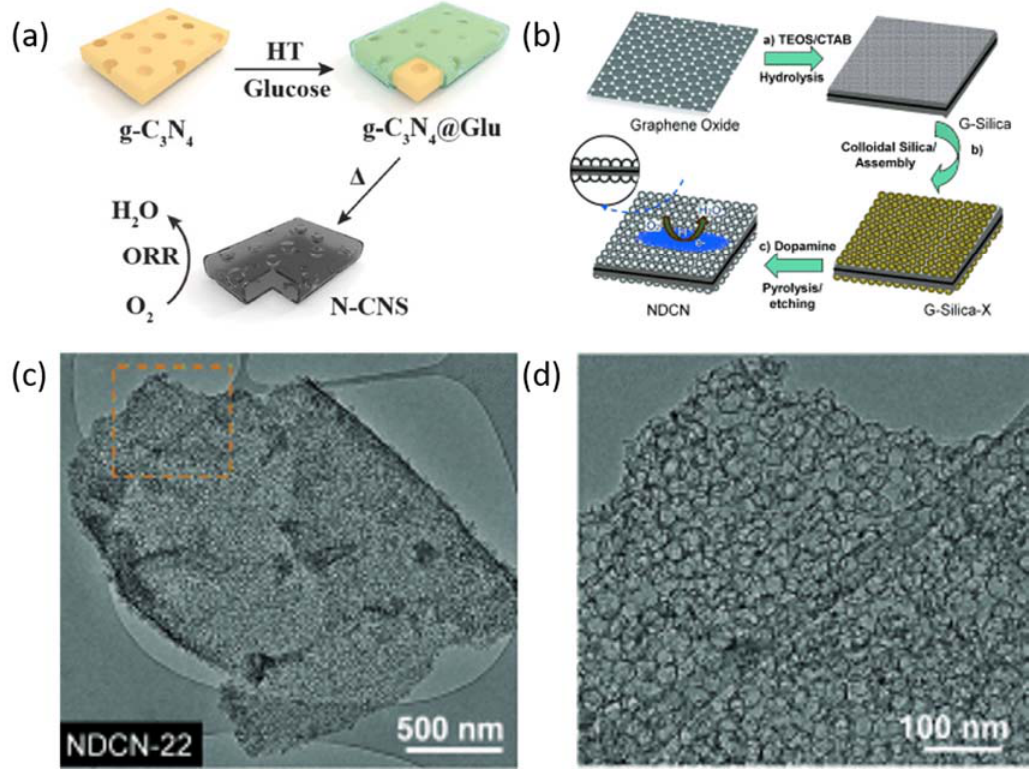
Figure 5. ( a ) Schematic for the synthesis of N ‐ CNS [93]. Copyright 2016, Wiley ‐ VCH. Copyright 2014, Wiley ‐ VCH. Synthesis of NDCN ‐ x ( b ) and corresponding TEM images of NDCN ‐ 22 ( c , d ) [30]. Copyright 2014, Wiley ‐ VCH.